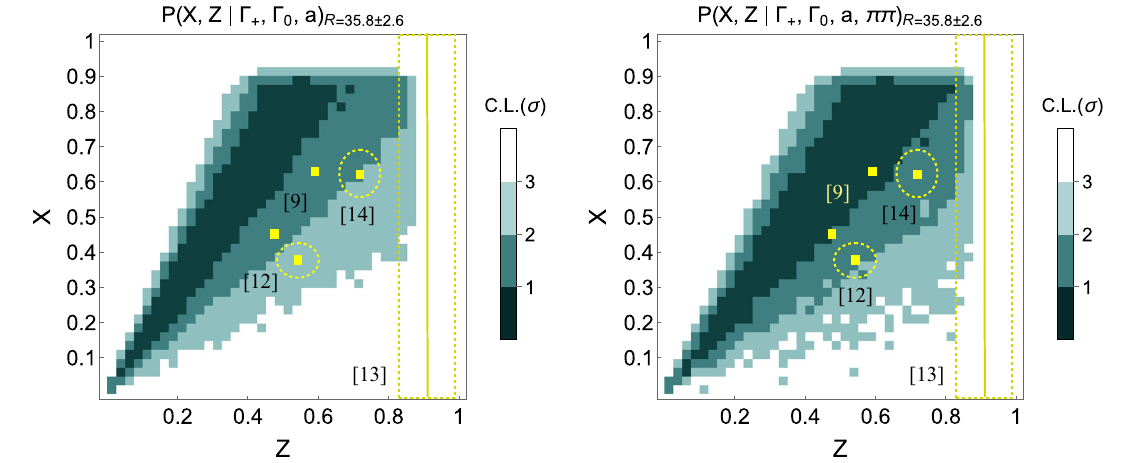
Fig. 2 Probability density P ( X , Z | data ) for R = 35 . 8 ± 2 . 6. Data points: results quoted in Table 2. Left: η → 3 π data. Right: η → 3 π and ππ scattering data